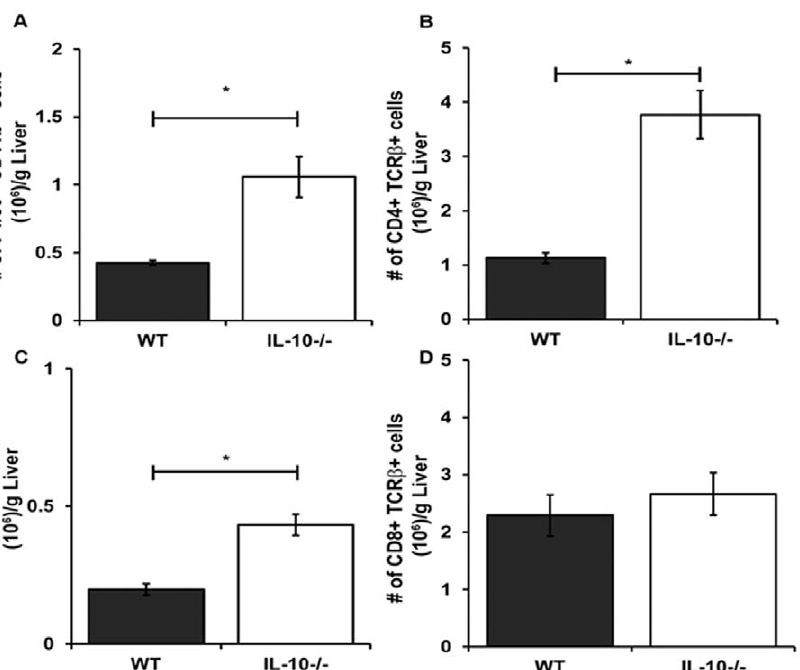
Figure 5. Persistence of effector cells in MCMV infected livers in the absence of IL-10. The numbers of (A) macrophages, (B) CD4 + T cells, (C) NK cells, and (D) CD8 + T cells in the livers of WT and IL-10 2 / 2 mice infected for 9 days were determined by flow cytometry. The mean numbers of cells per gram liver 6 SE are the combined data of four independent experiments (n=12–13 mice per group). Asterisks denote statistically significant differences between WT and IL-10 2 / 2 groups, where p values are # 0.05 (Student’s T test).